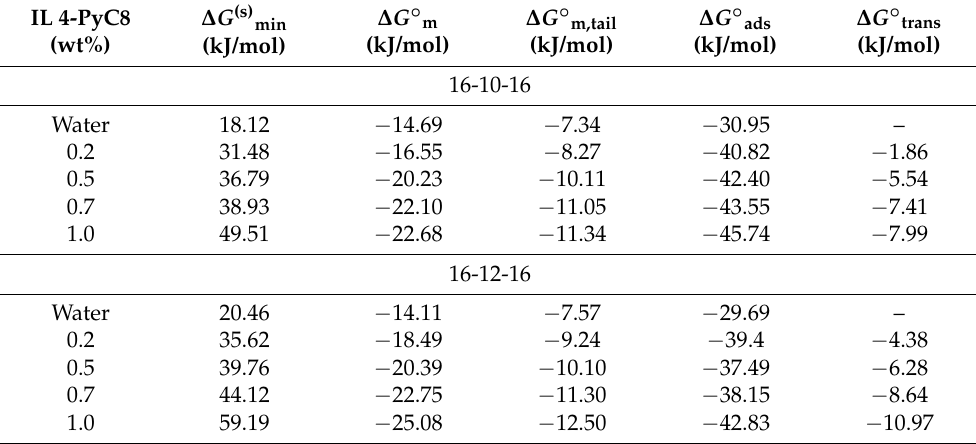
Table 3. Gibbs free energy of micellization ( ∆ G ◦ m ), Gibbs free energy of micellization per alkyl tail ( ∆ G ◦ m,tail ), Gibbs energy of transfer ( ∆ G ◦ trans ), standard free energy of adsorption ( ∆ G ads ) and Gibbs free energy of the given air/water interface ( ∆ G (s) min ) of the gemini surfactants 16-s-16 with different contents (wt%) of the IL 4-PyC8 at 300